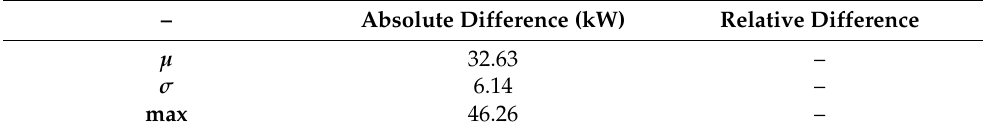
Table 10. Variation of daily peak of the grid active power feed during May 2020 between Scenario B and Scenario A. µ : average value, σ : standard deviation, max: maximum value.